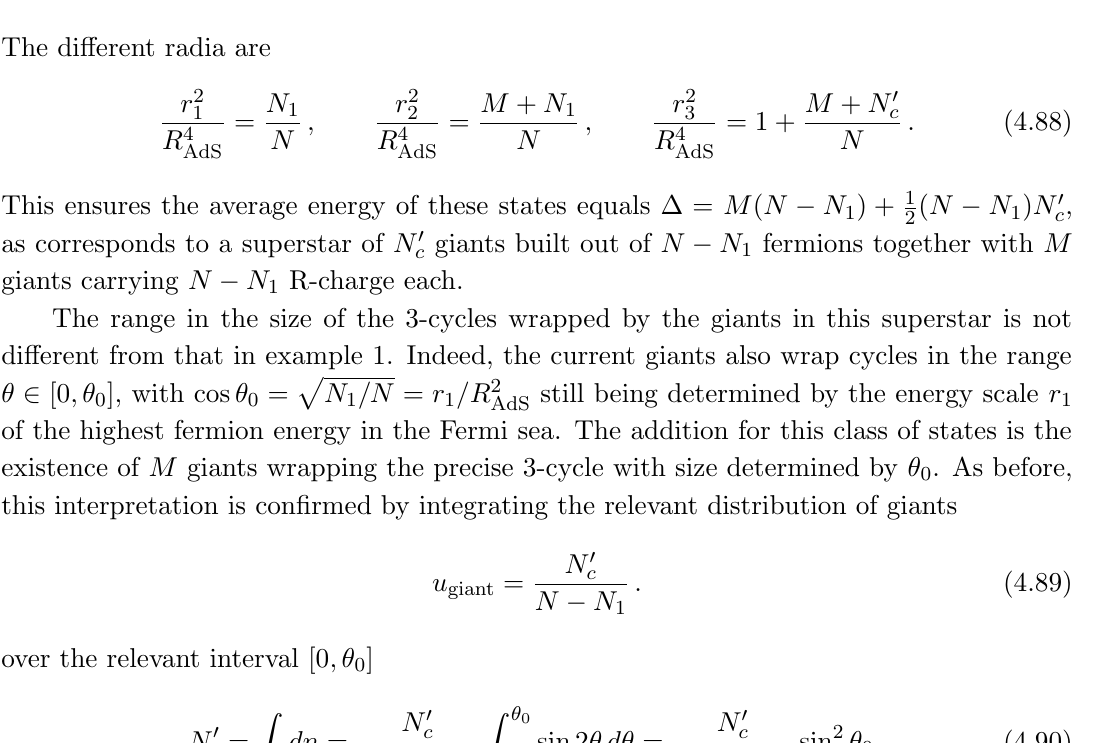
Figure 11 . Phase space density corresponding to a Fermi sea of N 1 fermions, followed by a gap and a localised